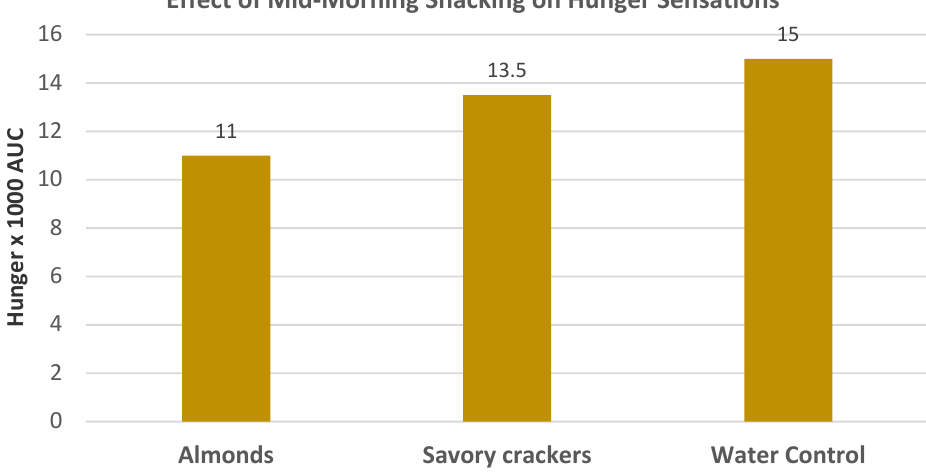
Figure 9. Effect of mid-morning snack on subjective ratings of hunger through dinner for almonds, savory crackers, and water control (almond vs. water p < 0.001 and almond vs. cracker p < 0.05) [40]. Zaveri et al. [41], in a parallel RCT, randomized 45 healthy men (mean age 40 years, mean BMI 30) to their habitual diet with the following added snacks: almonds (56 g, 3.9 g available carbs, 7.0 g fiber, 31 g fat, 12 g protein, 343 kcals) or cereal bar (60 g weight, 44